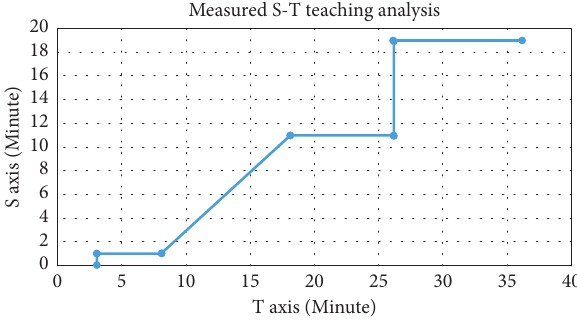
Figure 9: Visualization: S-T teaching analysis